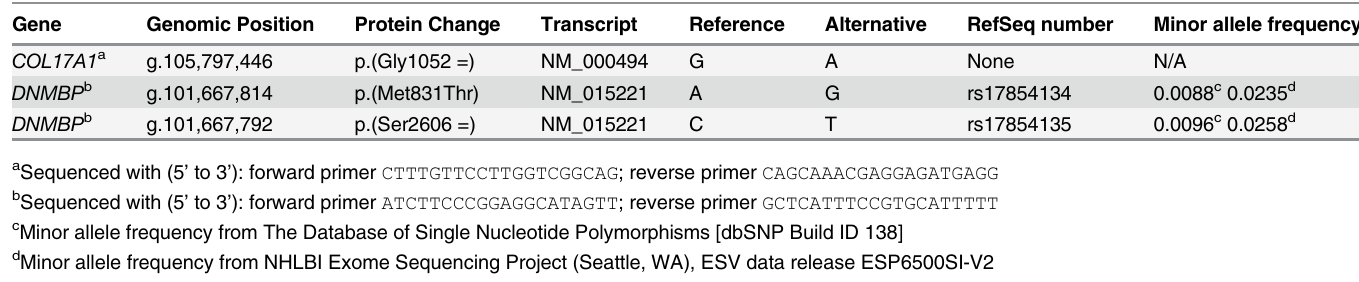
family members of undetermined affected status were screened for sequence variants that met each of the aforementioned filtering criteria using custom designed PCR primers (Table 1).